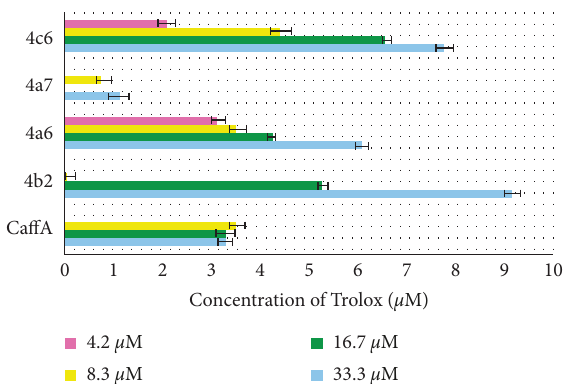
Figure 3: Ferric reducing antioxidant power of the tested sub- stances, applied in diferent concentrations (from 4 to 33 µ M) and expressed as the Trolox equivalent (TE).